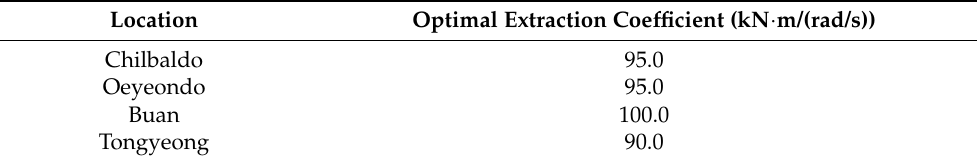
Figure 10. Average power production of the float according to the PTO extraction coefficient. Table 3. Optimal extraction coefficients at each location. Location